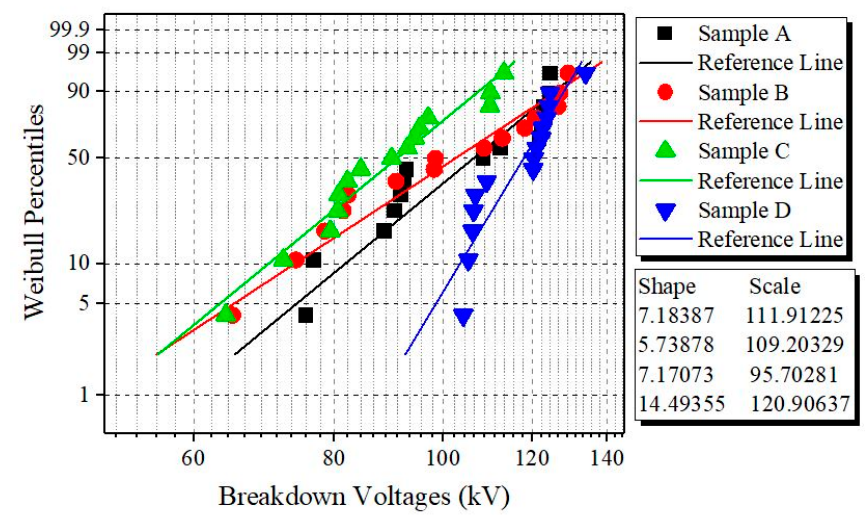
Figure 11. Weibull distribution results of fifteen lightning impulse breakdown data at various sample method preparations. Table 6. Probability of 1%, 50% and 90% lightning impulse breakdown voltage values of various oil samples with different treatments.